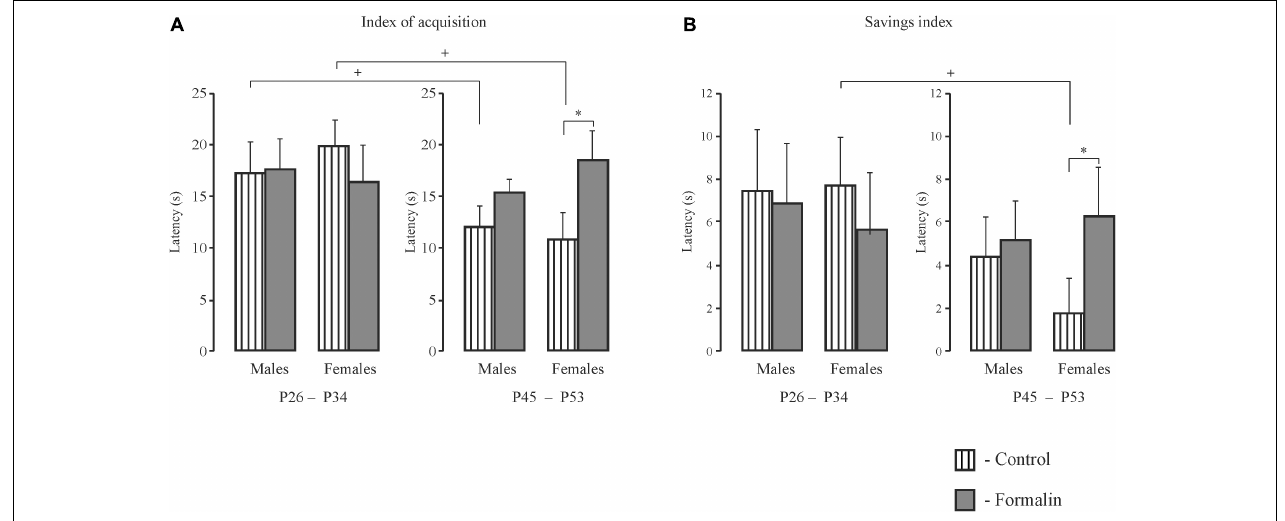
FIGURE 3 | The index of acquisition (A) and the savings index (B) for latency to find the platform during spatial learning in male and female rats of early (P26-34) and late (P45-53) age groups. The data are: Mean ( ± SEM) latency differences between the first and last training trials of each of the five training days of spatial learning (A) . Mean ( ± SEM) latency differences between the last training trial of a given day and the first training trial of the next day during the five-day spatial learning (B) . Both indices illustrate a decrease of latency to find the platform with age in Control rats; neonatal formalin-induced pain leveled the age differences. ∗ p < 0.05 Formalin vs Control (A,B) ; + p < 0.05 Control P45-49 rats vs Control P26-34 rats (A,B) . The number of the rats in the groups corresponds to the number of rats in Figures 1 , 2